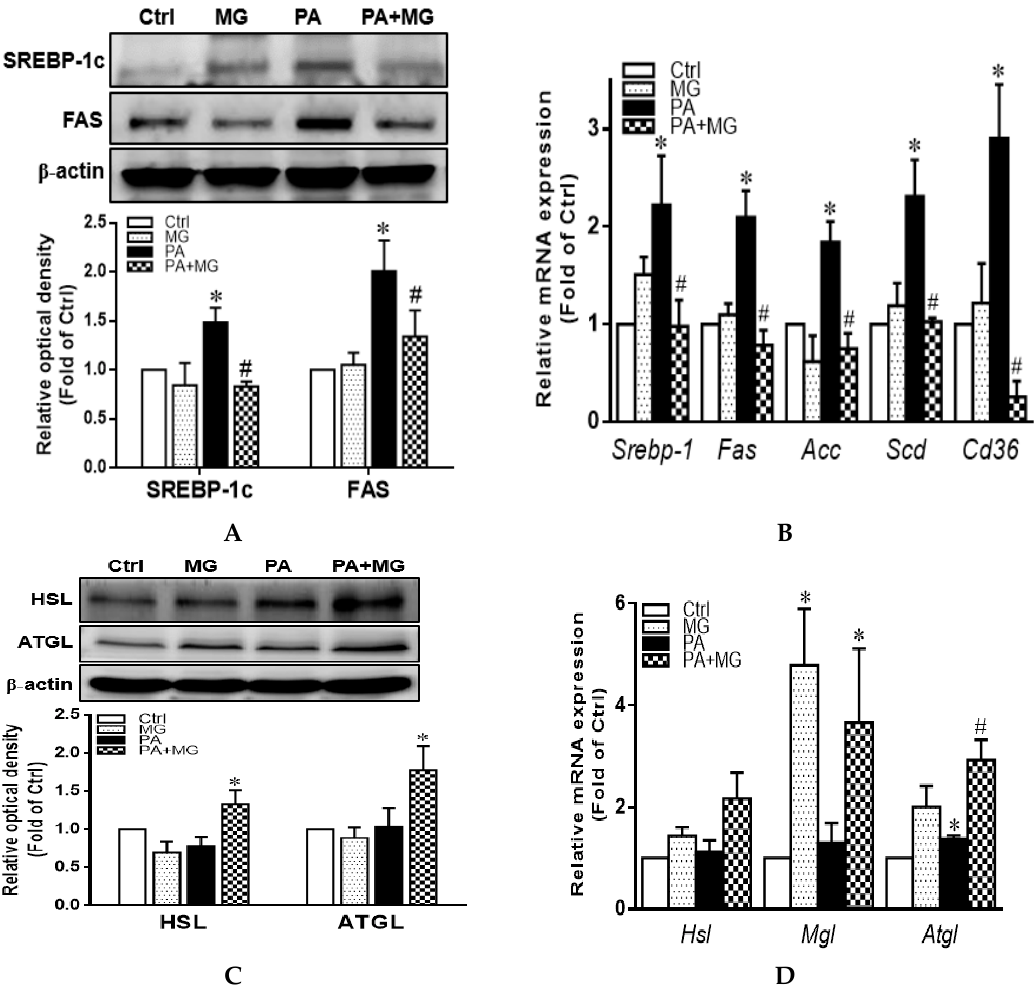
Figure 5. E ff ects of magnolol (MG) treatment on lipid homeostasis in steatotic HepG2 cells. ( A ) Representative Western blot and densitometry analysis of SREBP-1c and FAS; ( B ) relative mRNA expression of lipogenesis markers Srebp-1 , Fas , Acc , Scd , and Cd36; ( C ) representative Western blot and densitometry analysis of HSL and ATGL; ( D ) relative mRNA expression of lipolysis markers Hsl , Mgl , and Atgl . Data are expressed as mean ± SEM, n = 4. * p < 0.05 vs. Ctrl; # p < 0.05 vs. PA (palmitic